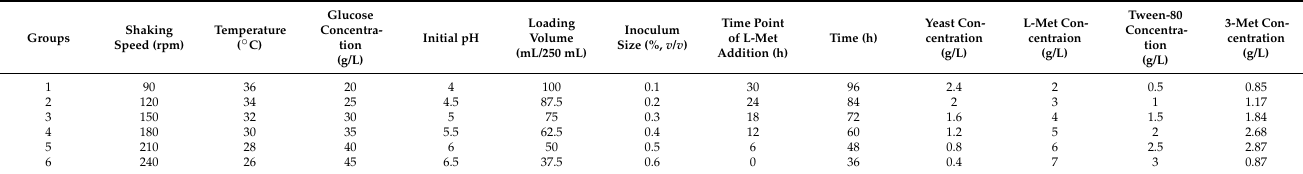
Table 3. Experimental designs and the results of steepest ascent for 3-Met